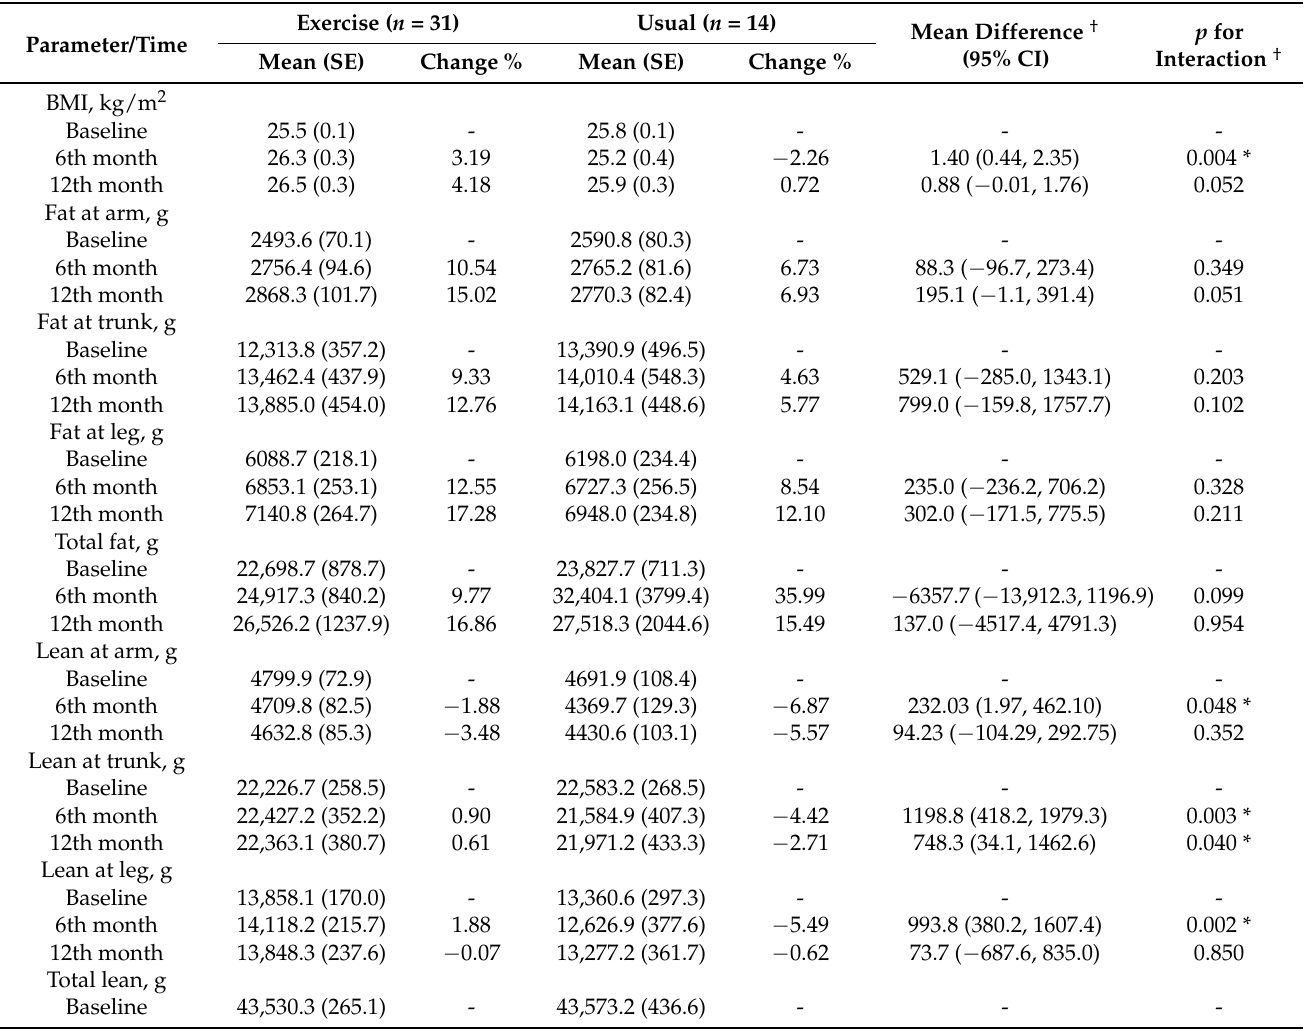
Table 2. The comparison of DXA parameters between the exercise and usual